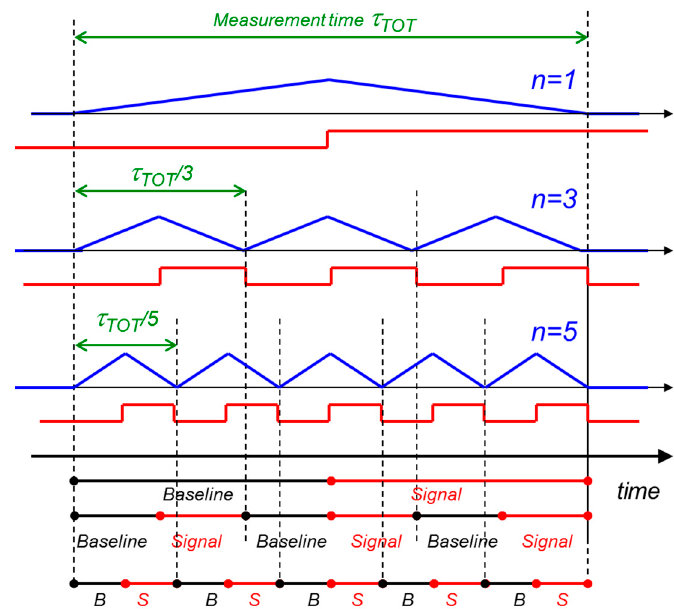
Figure 6. Schematic representation of the multiple non-destructive readout with fixed total measurement time τ TOT . In the upper drawing, only one readout of the signal (red line) is performed, exploiting the whole τ TOT . In the other two cases, the signal is reproduced and read out 3 and 5 times respectively. Since τ TOT is fixed, the time available for each single measurement is τ TOT /3 and τ TOT /5. The reduction of the shaping time for each single measurement (look at the blue weighting functions) turns out in an increased r.m.s. value of the white noise of the individual measurements. The averaging effect of the n readouts (3 and 5 respectively) compensates this noise increment. Therefore the ENC component related to the white voltage noise does not change with the number of measurements in a fixed time interval. For the 1/f noise the situation is different. The r.m.s. value of noise of one measurement is independent from the measurement time. This means a single measurement of time length τ TOT , τ TOT /3 or τ TOT /5 would result in the same r.m.s. noise. In this case, the averaging effect of n measurements makes the ENC go down with approximately √ n. In the figure only the positive step of the signal is measured, i.e. , the signal is measured only when it is injected into the internal gate. In theory it would be possible to measure the signal charge also when it is removed from the internal gate, evaluating the falling edge of the DEPFET output. This would increase of a factor two the number of measurements for a certain number of charge transfers.